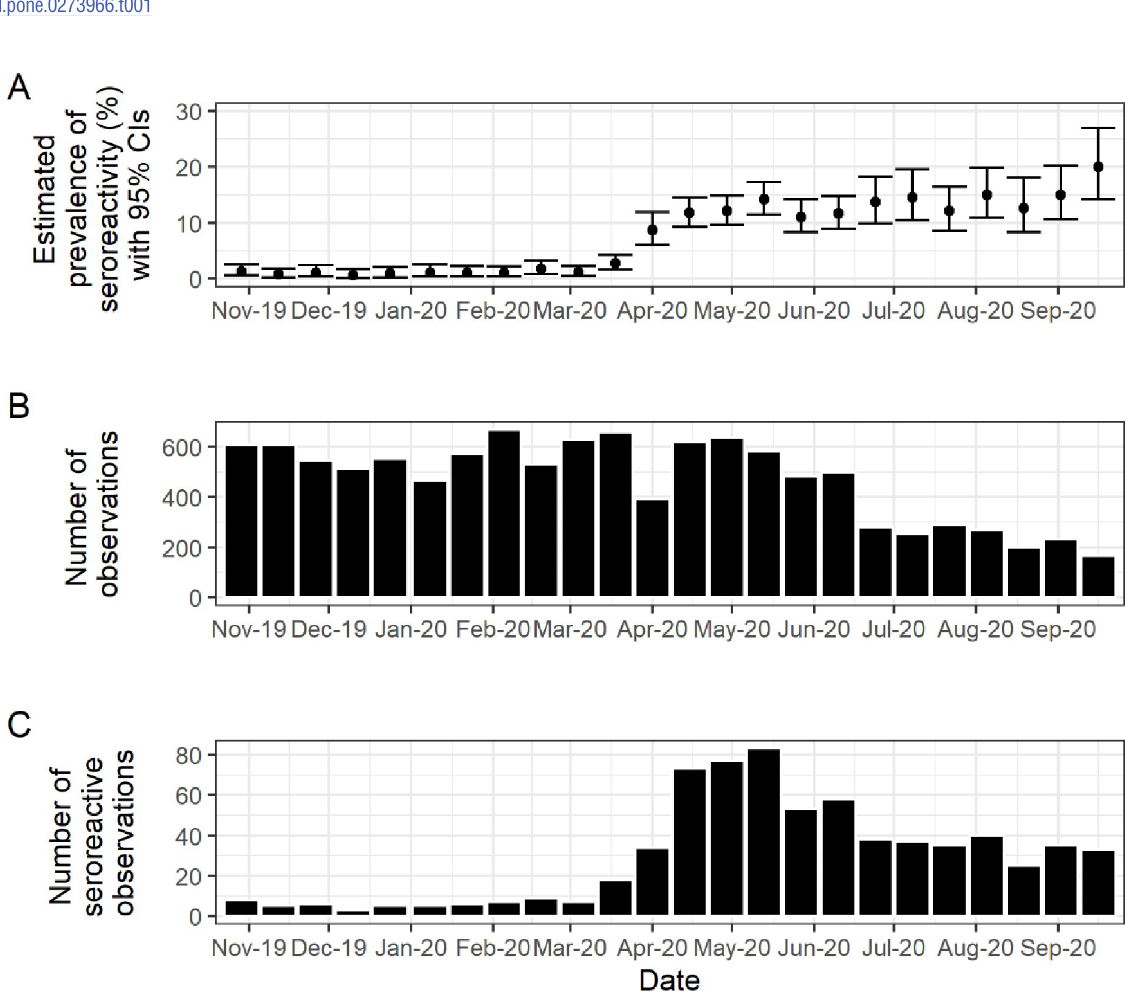
Fig 2. Prevalence of seroreactivity over time. (A) Estimated prevalence of seroreactivity over time with exact binomial 95% confidence intervals. (B) Total number of observations per fortnight. (C) Number of seoreactive observations per fortnight.